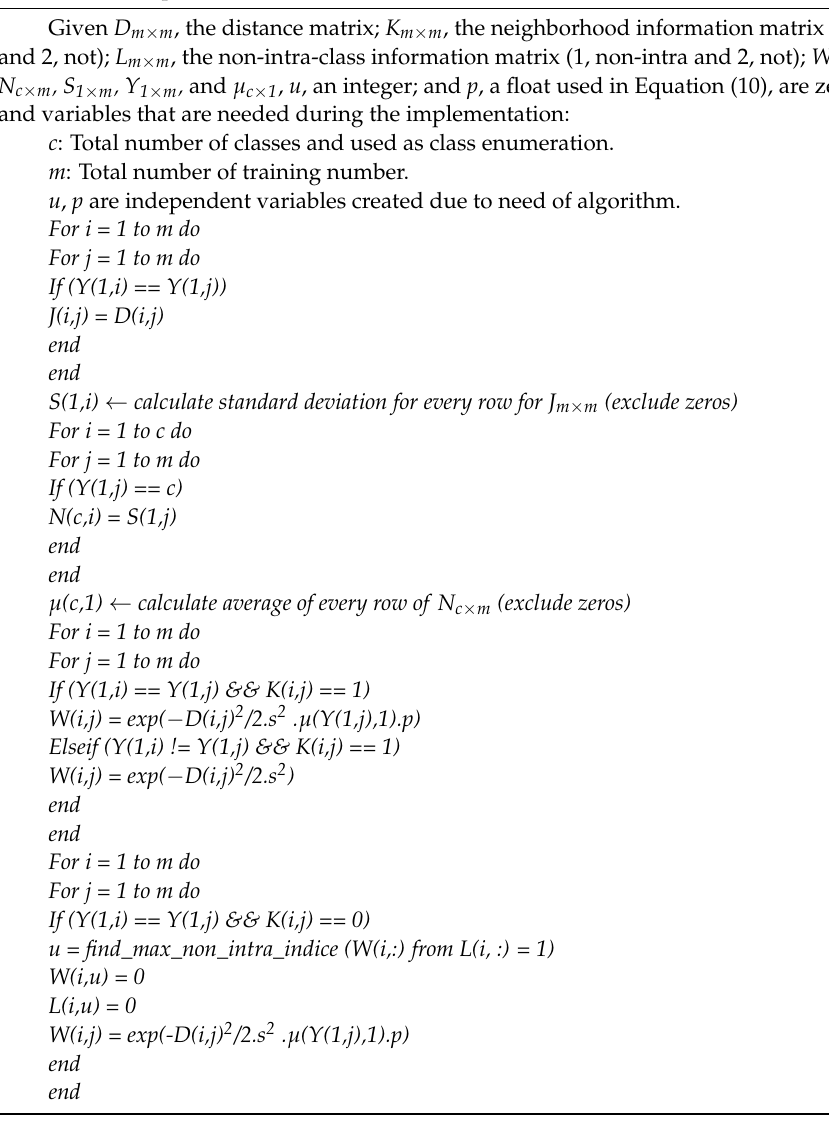
Algorithm 1 Proposed